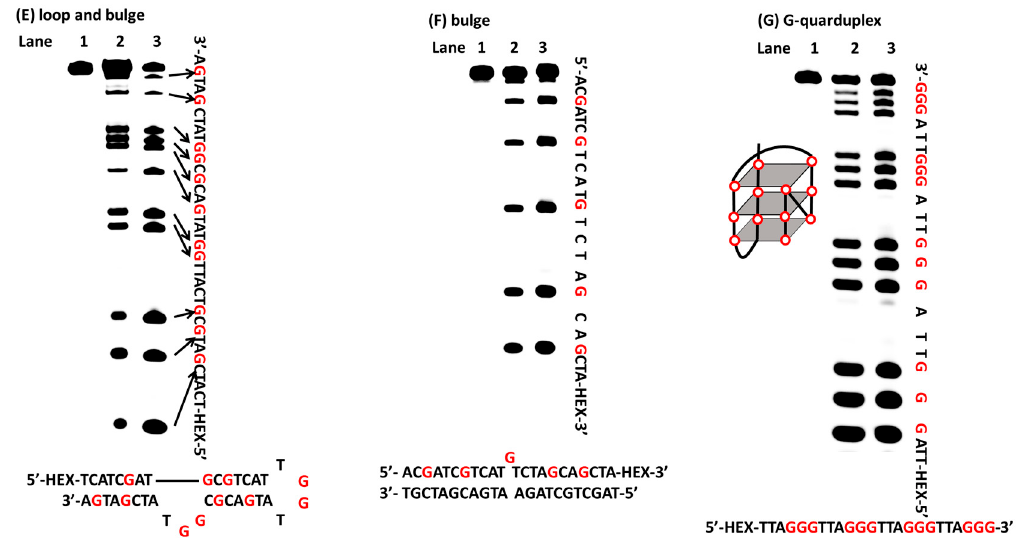
Figure 2. Polyacrylamide gel electrophoresis analysis of DNA. The oxidized DNA treated with piperidine at 90 °C for 40 min. ( A ) Cleavage of the hairpin-loop structure; ( B ) Cleavage of the double strand structure; ( C ) Cleavage of the terminal structure; ( D ) Cleavage of the mismatch structure; ( E ) Cleavage of the loop and bulge structure; ( F ) Cleavage of the bulge structure; ( G ) Cleavage of the G-quadruplex structure.